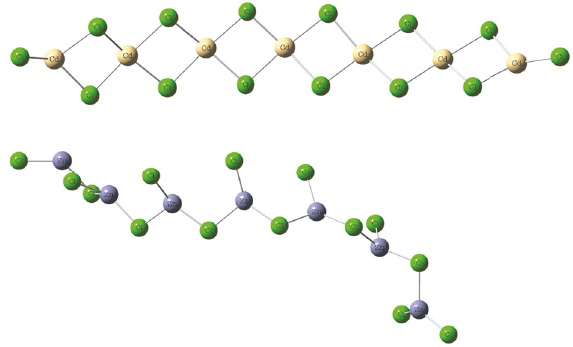
Figure 1: Examples of the two types of inorganic polymeric struc- tures adsorbed on PVA. Organic portion is not shown for the sake of clarity.